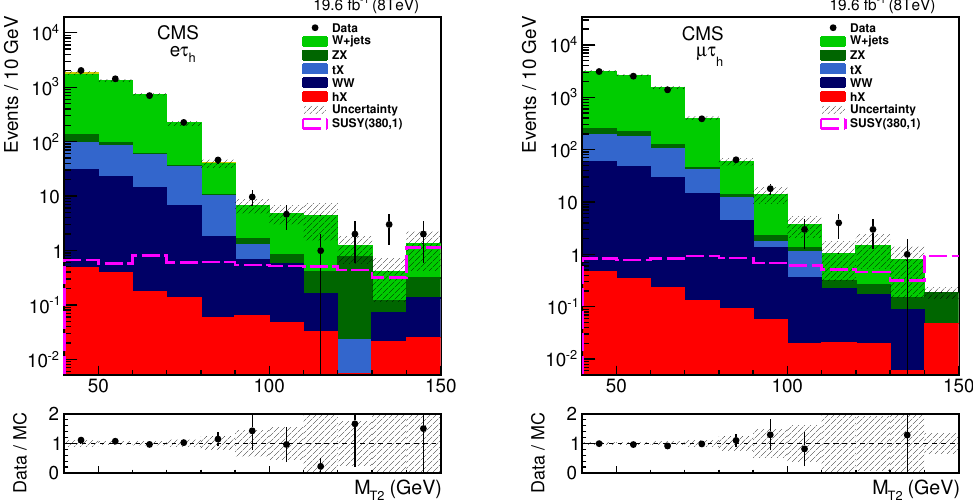
(cid:28) h , compared T